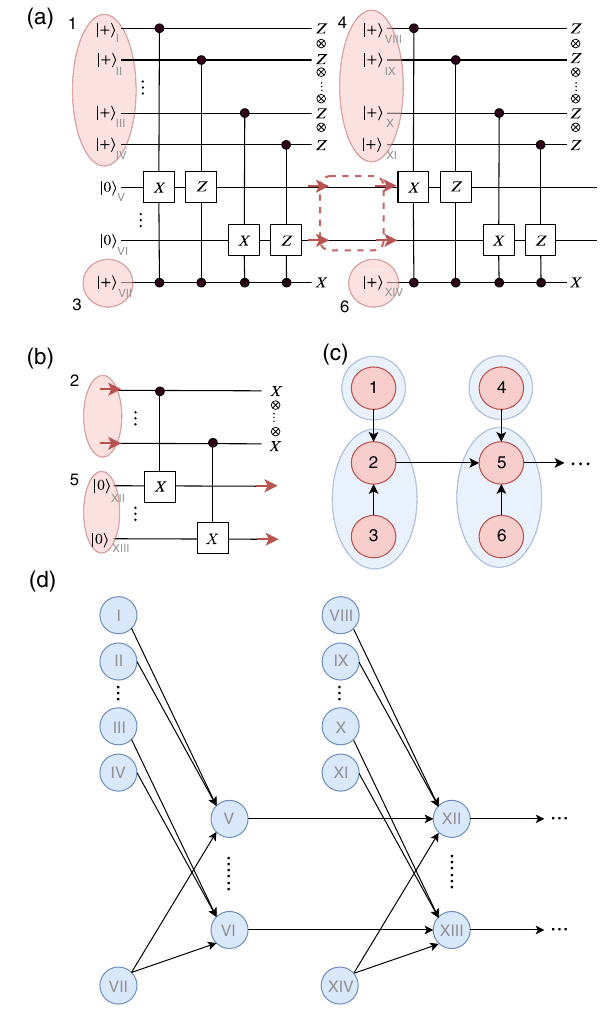
FIG. 5. (a) Quantum circuits for generating all of the possible stabilizer states by measurements. Circles 1 and 4 are super- positions of 2 n -bit strings with uniform weights, of which measurement results in the Z basis determine which stabilizers are to be measured for the qubits initialized as j 0 i ⊗ n (those qubits in the middle). The measurement results in the X basis of circles 3 and 6 give the outcome of measuring the corresponding Pauli determined by the measurement result of circles 1 and 4, respectively. With all of the outcomes of circles 1,3,4,6, (cid:2) (cid:2) (cid:2) , the qubits in the middle can be any possible stabilizer state. (b) Teleportation gadget for the part in the red dashed box of diagram (a). The stabilizer to be measured in the next time step should be determined by measurement results of both 2 and 5 because the measurement result of 2 will sometimes produce some Pauli corrections. (c) Corresponding Bayesian network circuit of (a) after using (b). All of the red circles correspond to circles in (a) and (b) with the same number labels. We group f 1 g , f 2 ; 3 g and f 4 g , f 5 ; 6 g as blue circles to form a 2-gram model with input, which is a special case of the translation form of the HMM given in Fig. 1(b). (d) 2D arrangement of the Bayesian network for the circuit shown in (a). The correspondence between quantum circuits and circles is labeled by Roman